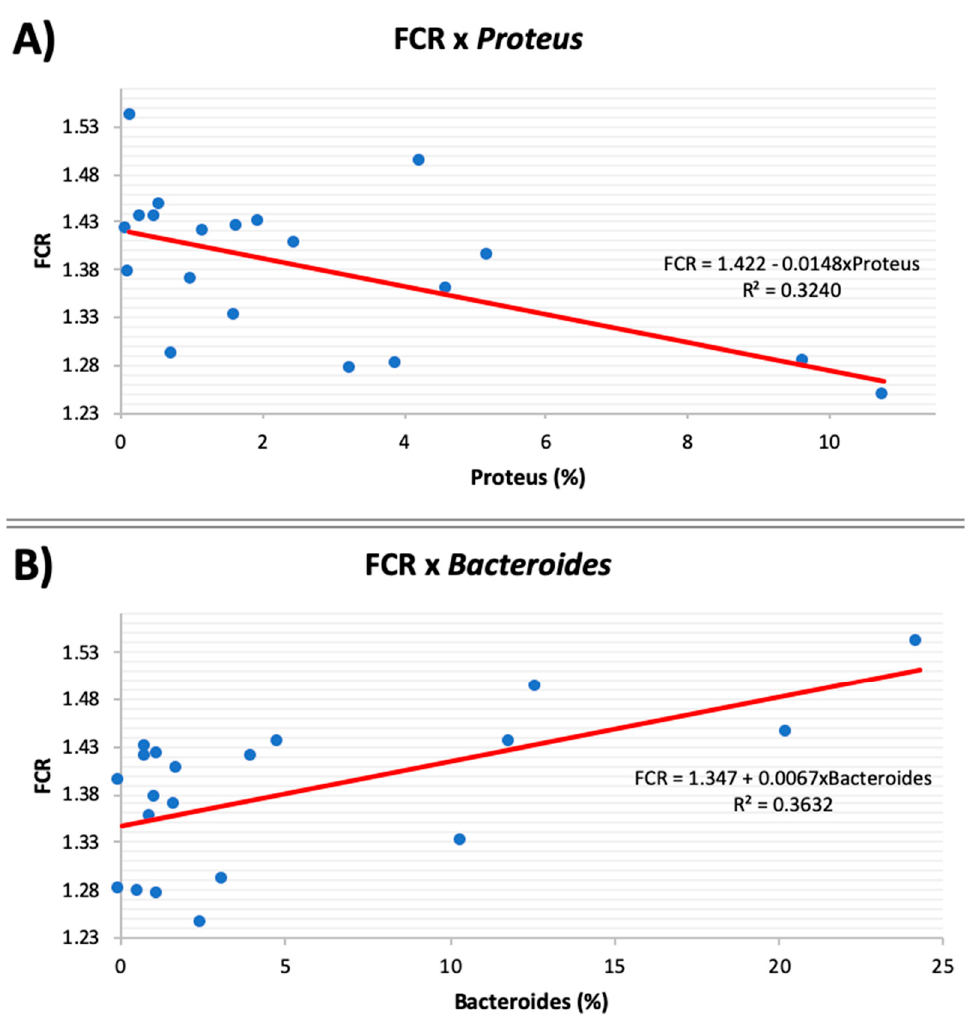
Figure 2. Relationship between overall feed conversion ratio (FCR) and abundance of the genera Proteus ( A ) and Bacteroides ( B ). Proteus had a negative correlation ( ρ = − 0.57; p = 0.009) with FCR. Bacteroides had a positive correlation ( ρ = 0.60; p = 0.005) with FCR.